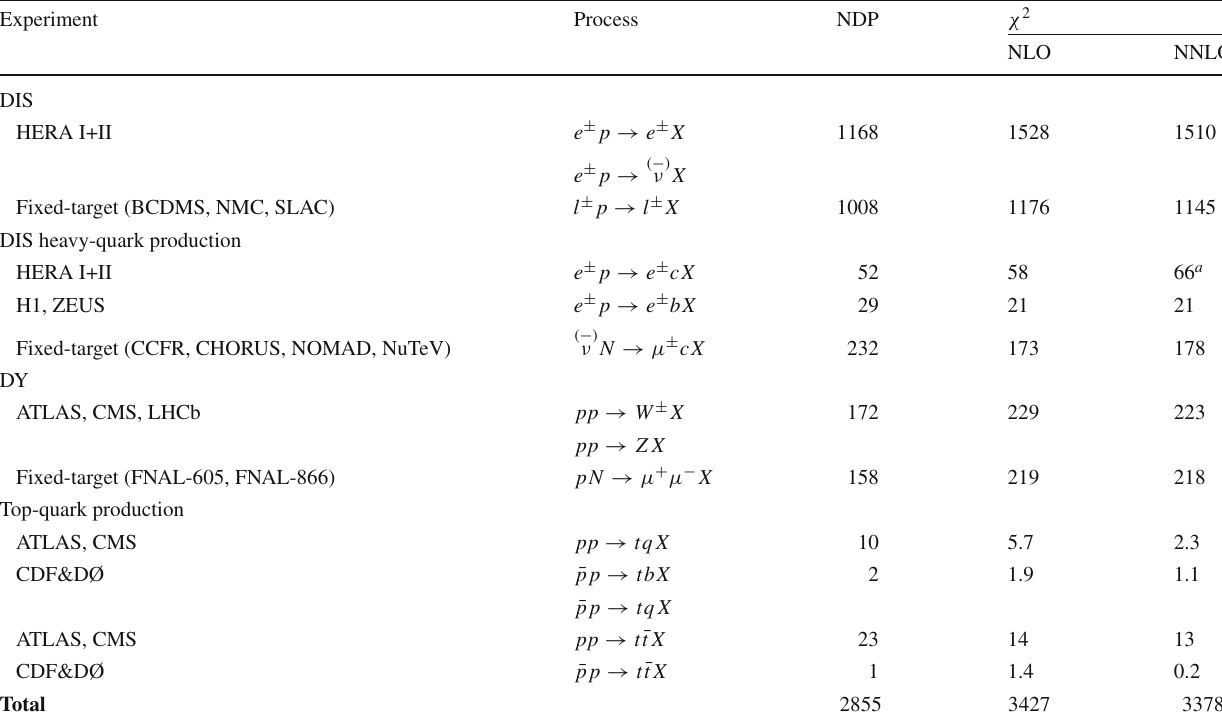
Table 1 The values of χ 2 obtained in the present analysis at NLO for the data on inclusive DIS, the DY process, and on heavy-quark production in comparison with the ones of the ABMP16 fit at NNLO [4]. a This value corrects a misprint in Table V of Ref.